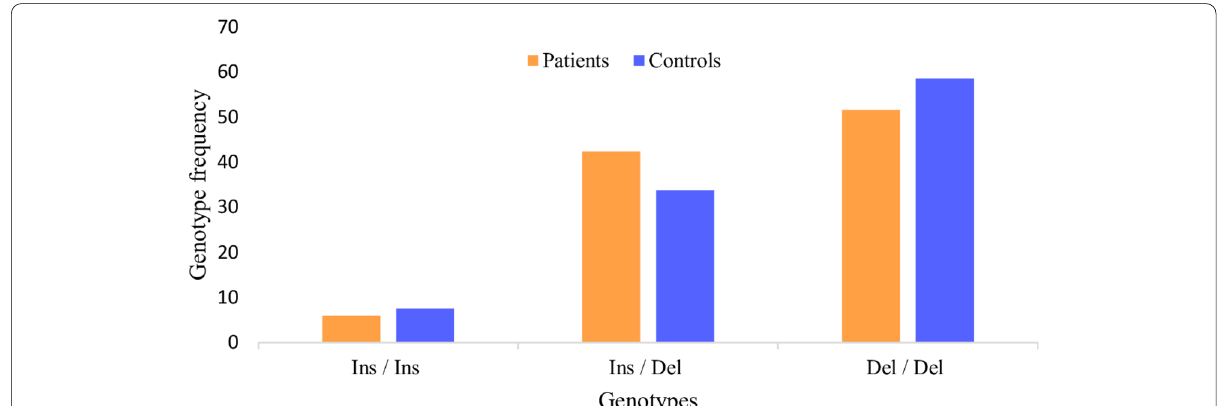
Fig. 1 Distribuição das frequências genotípicas para o marcador rs4646994 ( ACE ) no grupo de pacientes de TB e grupo